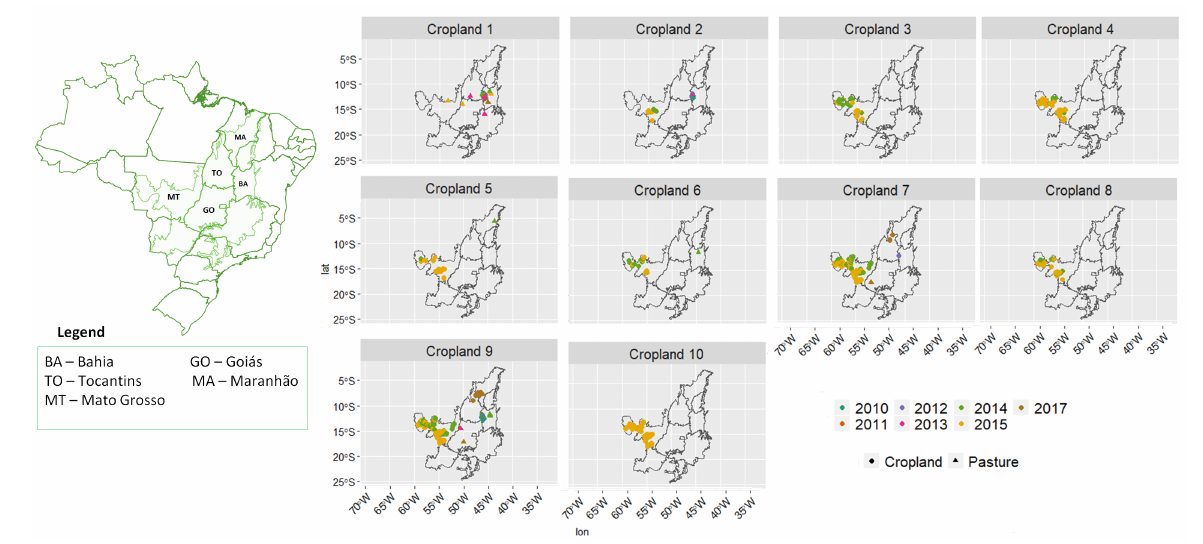
Figure 8. Clusters of cropland. Spatial location, by cluster, where the samples